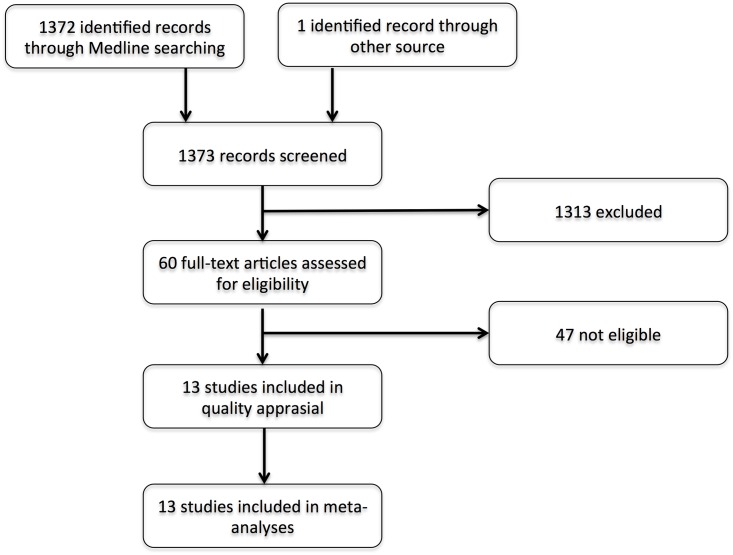
Flow diagram of the published articles evaluated for inclusion in this meta-analysis.